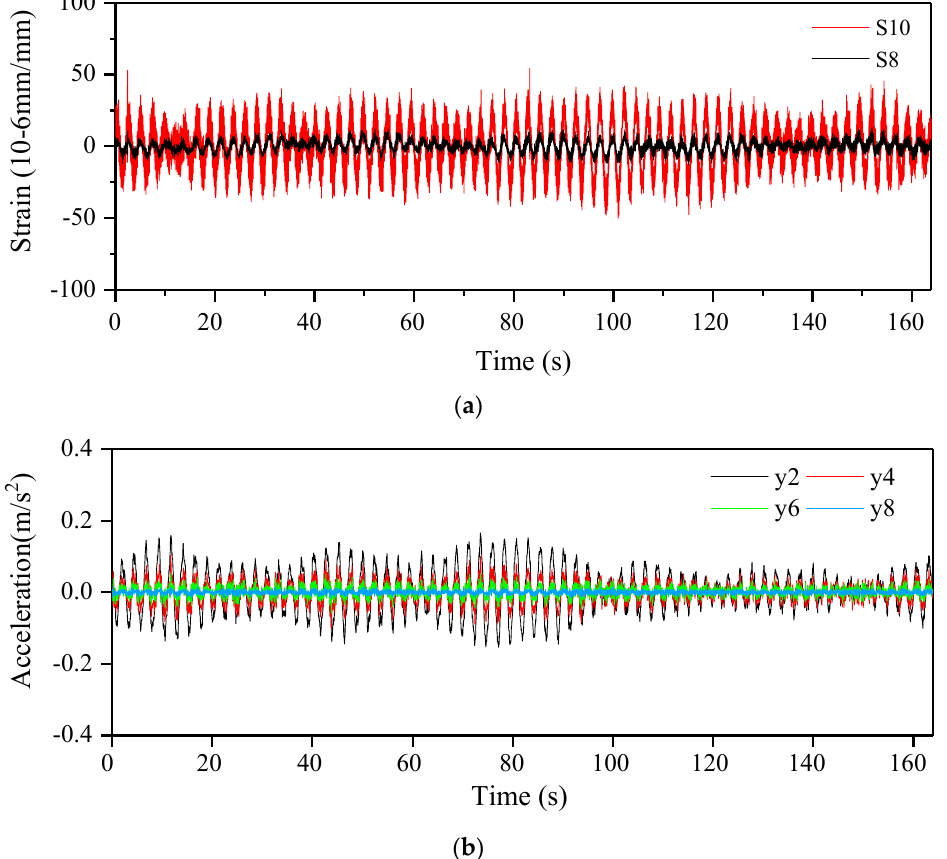
Figure 9. Typical vibration signals acquired by different sensors with 8192 sampling points: ( a ) Vibration signals from strain gauges along the main wind direction (MWD); ( b ) vibration signals from accelerometers along the MWD.